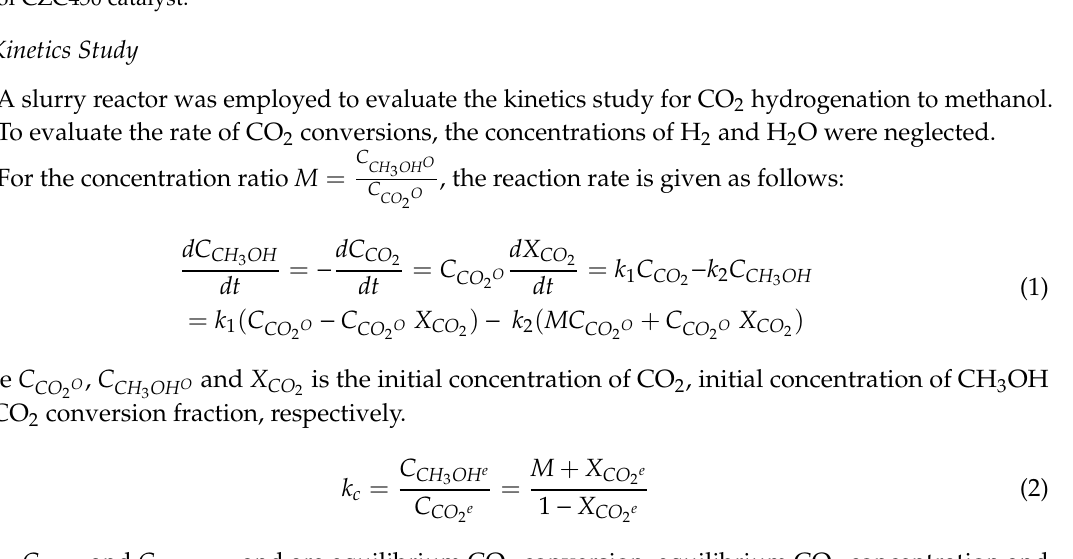
Figure 1. ( a ) X-ray diffraction (XRD) spectrum; and ( b ) transmission electron microscopy (TEM) image of CZC450 catalyst.